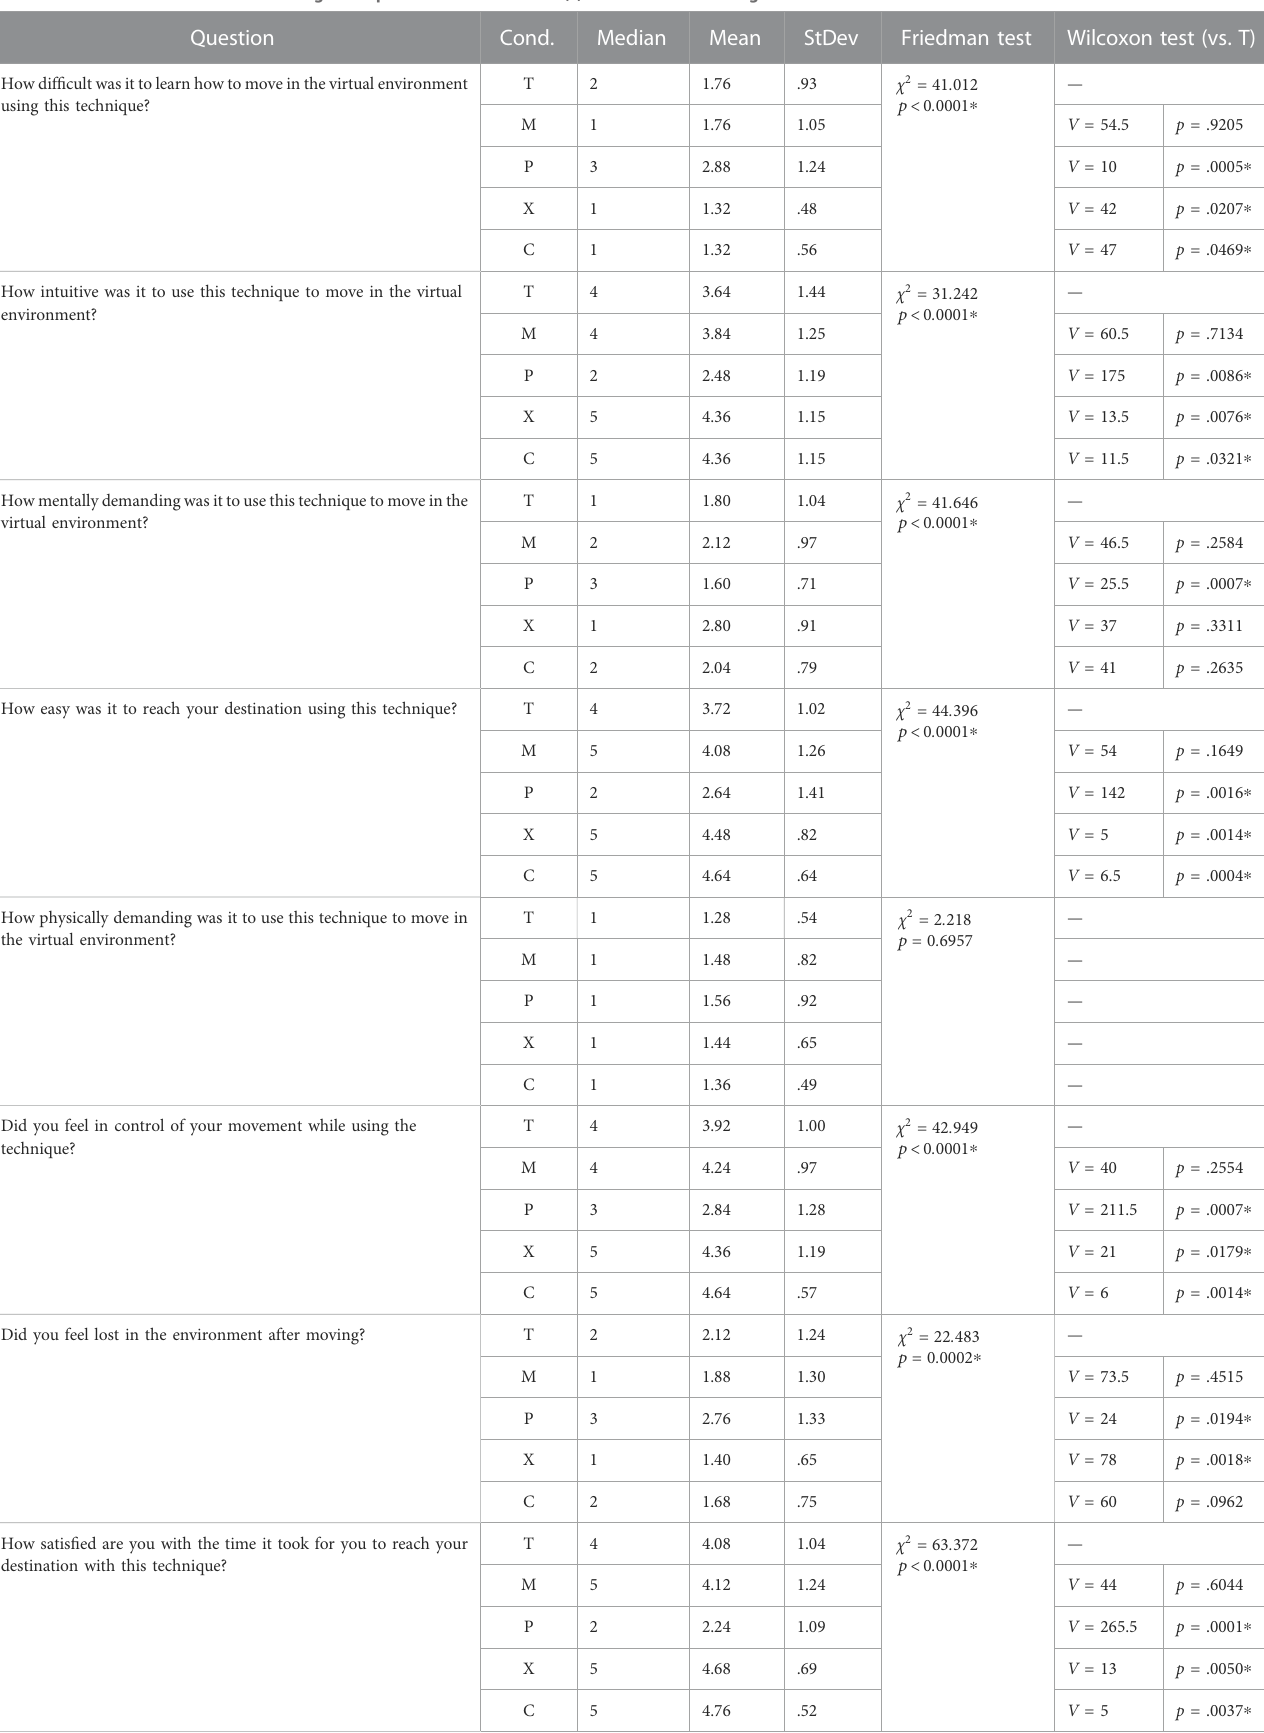
TABLE 3 Statistical test result of the navigation questionnaire. Asterisks (*) indicate statistical signi fi cance. Question Cond. Median Mean StDev Friedman test Wilcoxon test (vs. T) Howdif fi cultwasittolearnhowtomoveinthevirtualenvironment using this